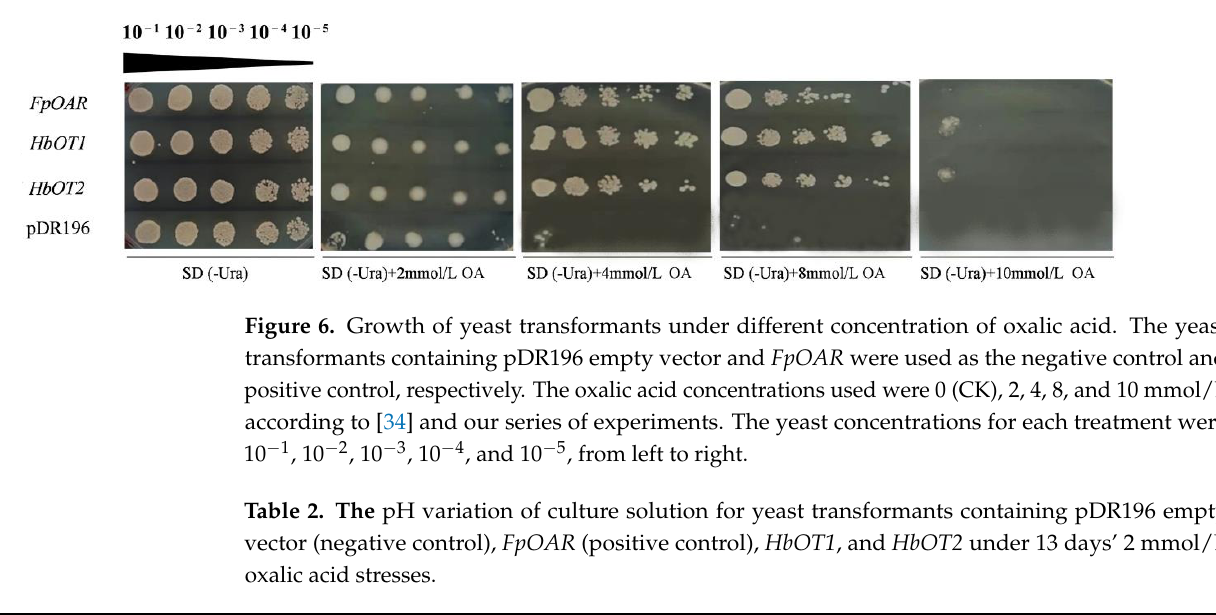
Note: Different uppercase letters show significant differences in treatment time, and different lowercase letters imply significant differences in yeast transformants ( p < 0.05), the same in the following tables.